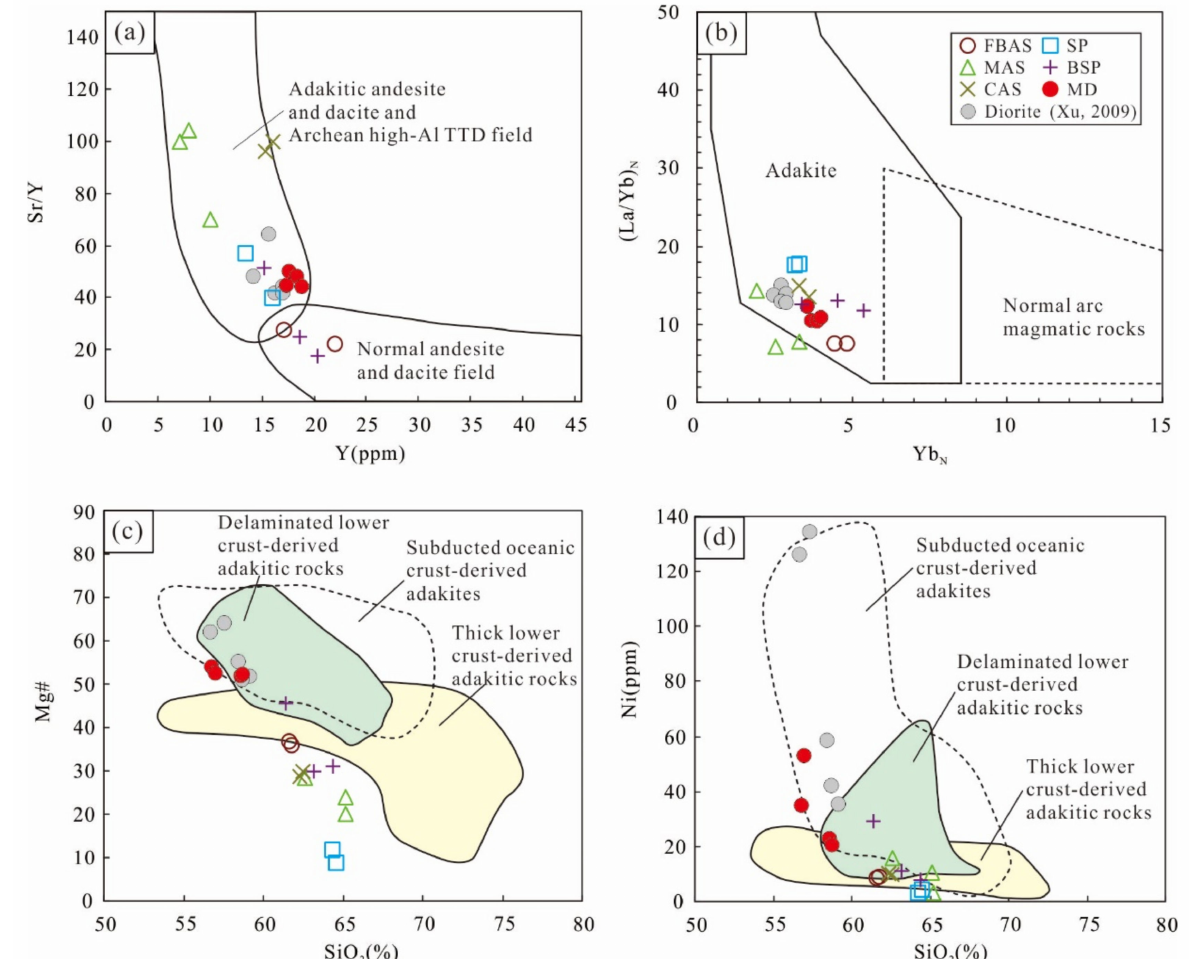
Figure 12. ( a )The Y versus Sr/Y and ( b ) the Yb versus La/Yb diagrams [63,64]; ( c ) The SiO 2 versus Mg # and ( d ) the SiO 2 versus Ni diagrams